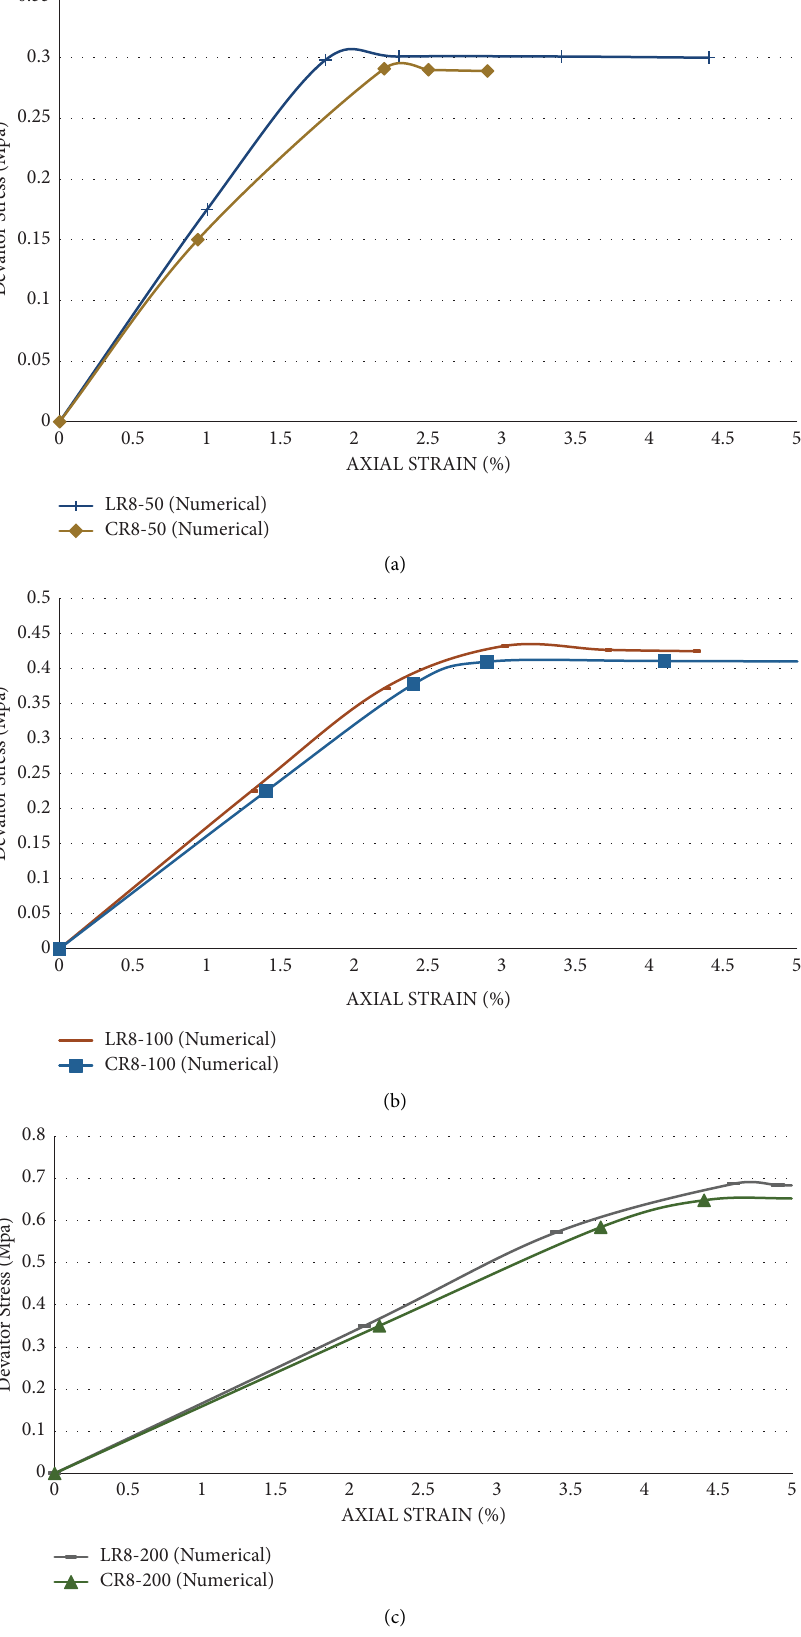
Figure 13: Comparison between deviator stress-strain curves for 8% CRHA and 8% LRHA treated soil (1:2) after 28 days of curing, under three diferent confning pressures of (a) 50, (b)100, and (c)